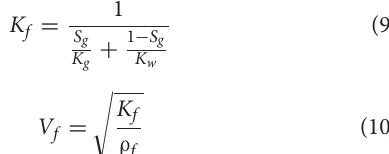
solid matrix. a is the crack radius; r is the aspect ratio; η is the